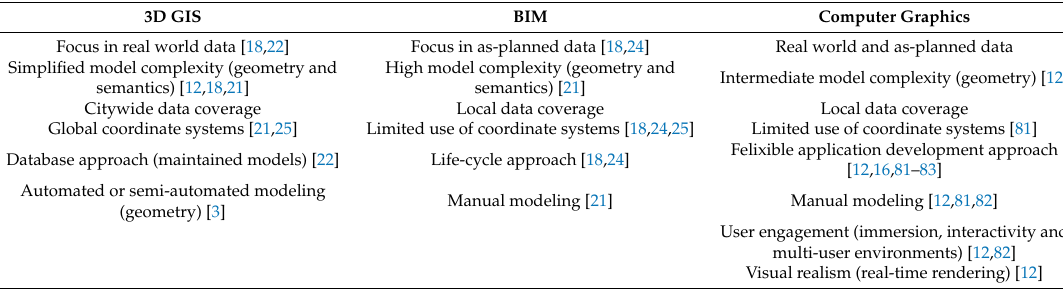
Table 4. The characteristics of the operational cultures in 3D city modeling.